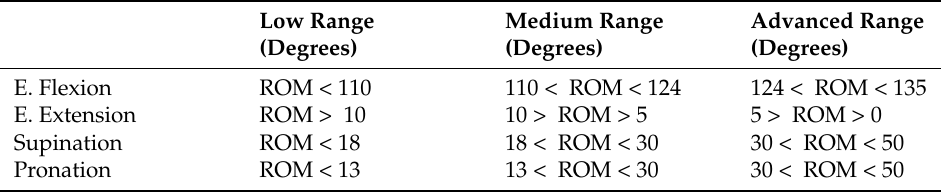
Table 2. Elbow Range Division.